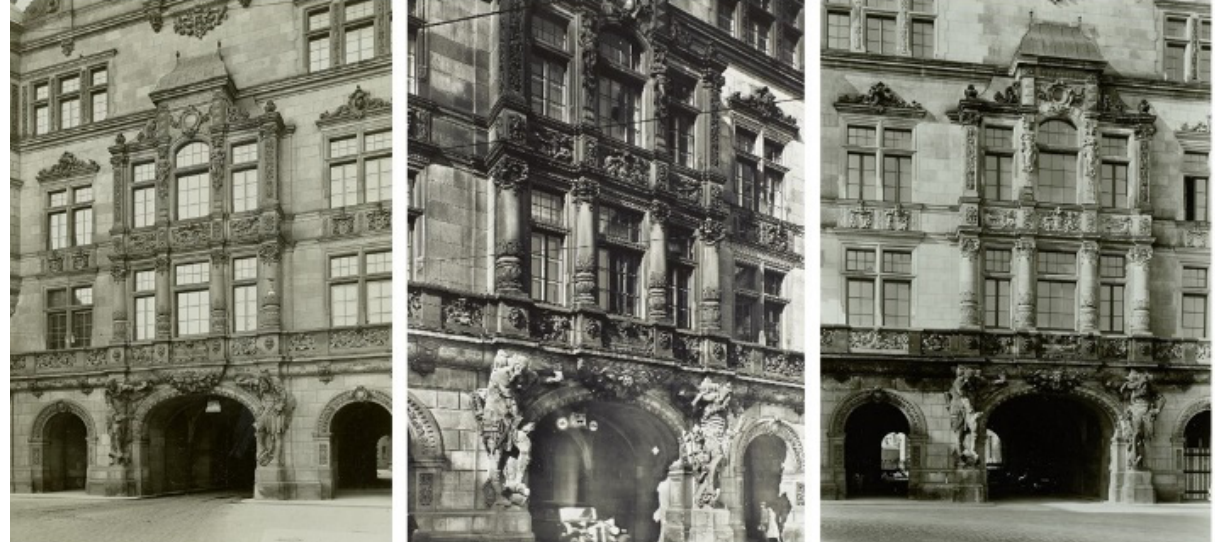
Figure 1. Example that shows radiometric differences between three historical images of the same